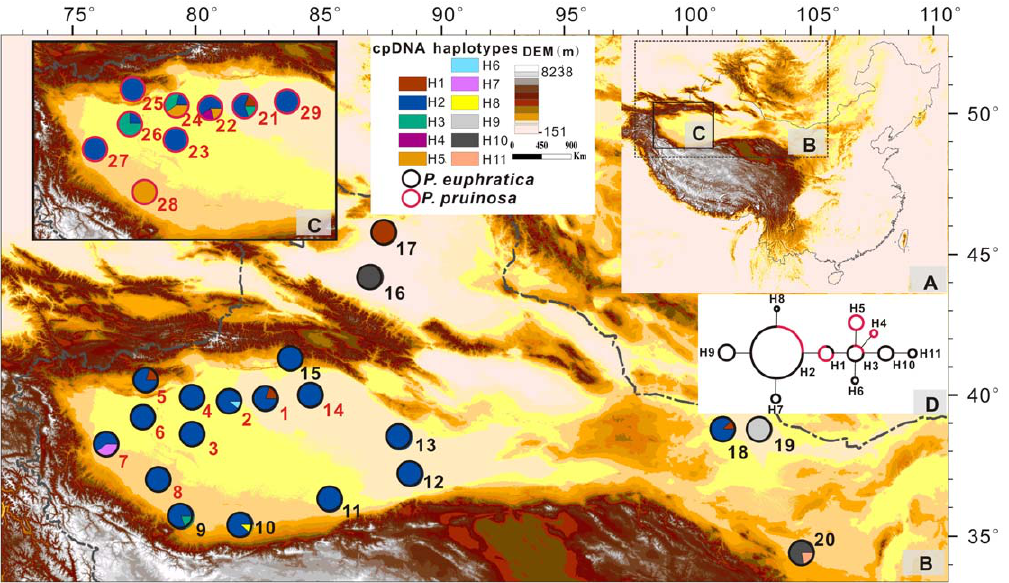
Figure 1. Sampling sites and chlorotype frequencies in the examined populations of the two poplar species. (A) Map of China. (B) Chlorotype frequencies of P. euphratica . (C) Chlorotype frequencies of P. pruinosa . (D) Network of the chlorotypes. Populations marked in red indicate the sites where the two species grow sympatrically. Circle size is proportional to chlorotype frequency, with the largest circle representing the most common haplotype.